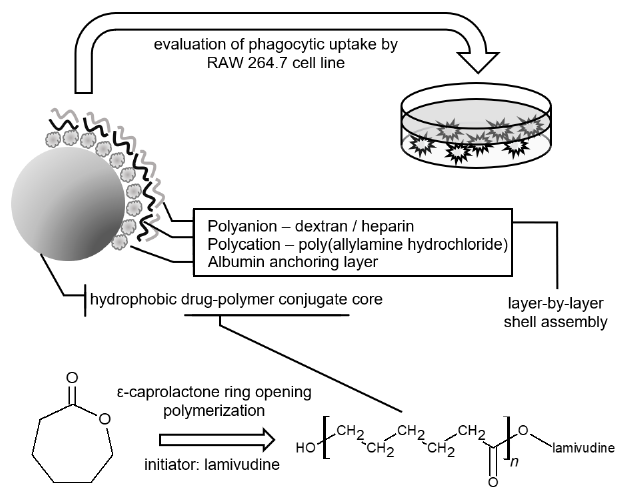
Figure 1. Schematic conception of the development of the lamivudine-poly- ε -caprolactone conjugate particles for intra-macrophagic drug delivery.